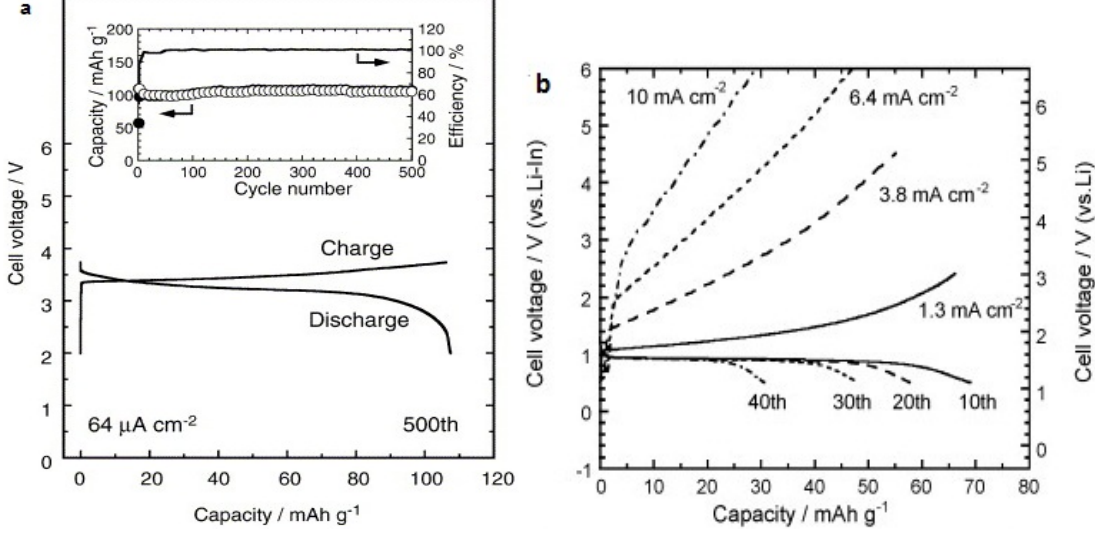
Figure 5. ( a ) Charge-discharge curves and cycling performance at 64 μ A cm − 2 for the 500th ( b ) Charge-discharge curves of the all-solid-state Li-In/70Li cell (discharge always at 64 μ A cm − 2 ) [35].